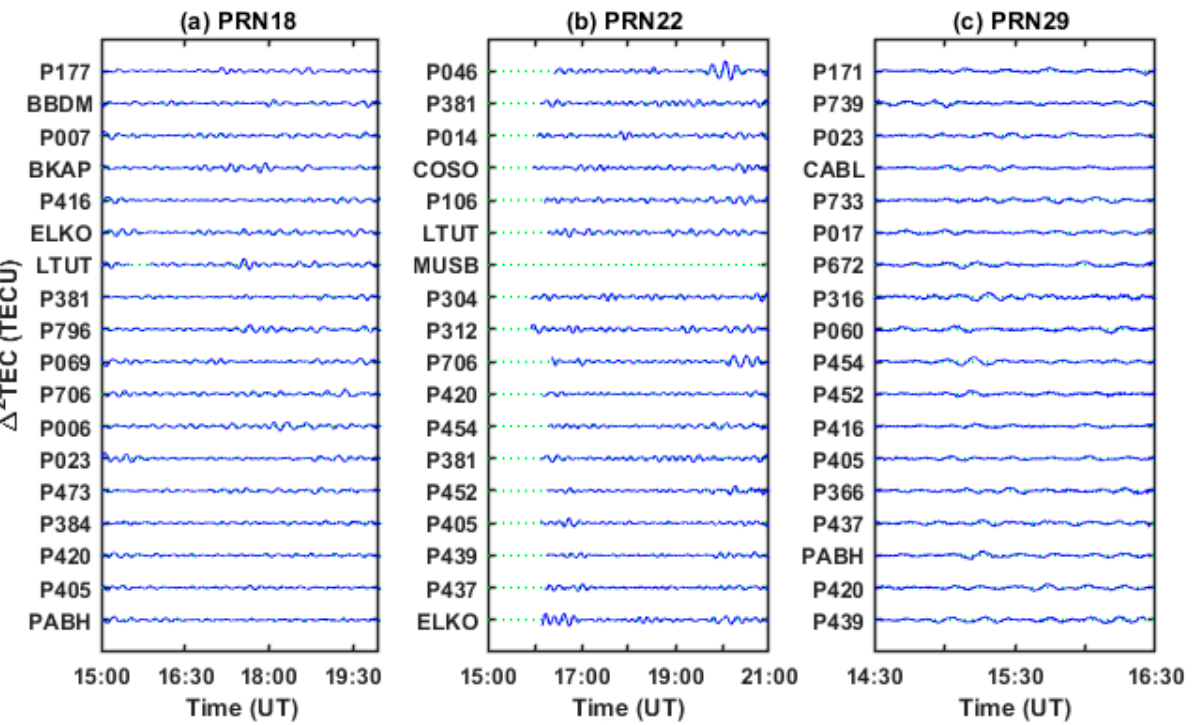
Figure 9. ∆ 2 TEC time series of PRN 18, PRN22, and PRN29 observed from different GPS stations between 14:30 UT and 21:00 UT on 10 March (a day before the tsunami). Results from each station are vertically shifted from the previous station by two TECU in ( a ) and ( b ), and results from each station are vertically shifted from the previous station by one TECU in ( c ).